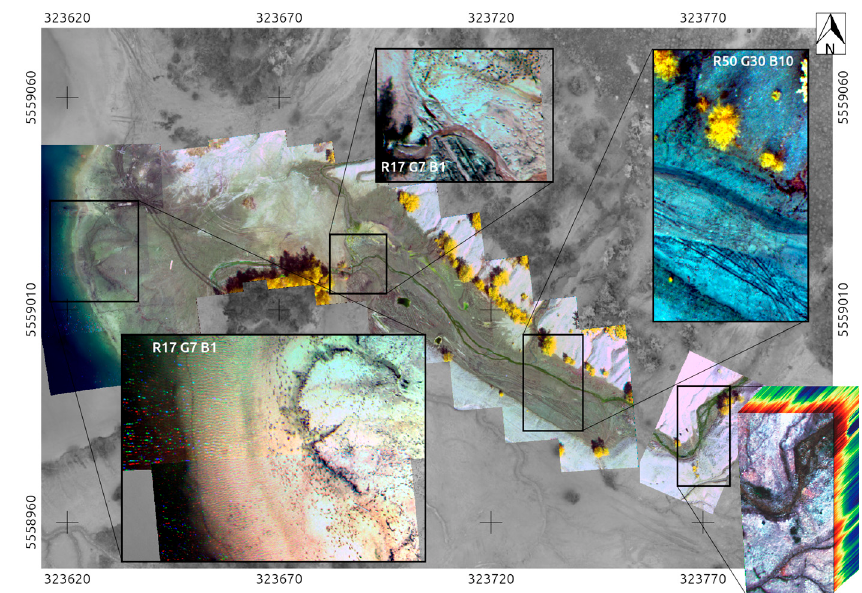
Figure 7. HSI scenes of July are superimposed with enhanced outcrops of September HSI, to showcase the level of detail. The pixel size of the HIS approximates 4 cm. Shown underneath is an orthophoto, obtained by the eBee UAS. The hypercube in the lower right corner illustrates the added spectral dimension.